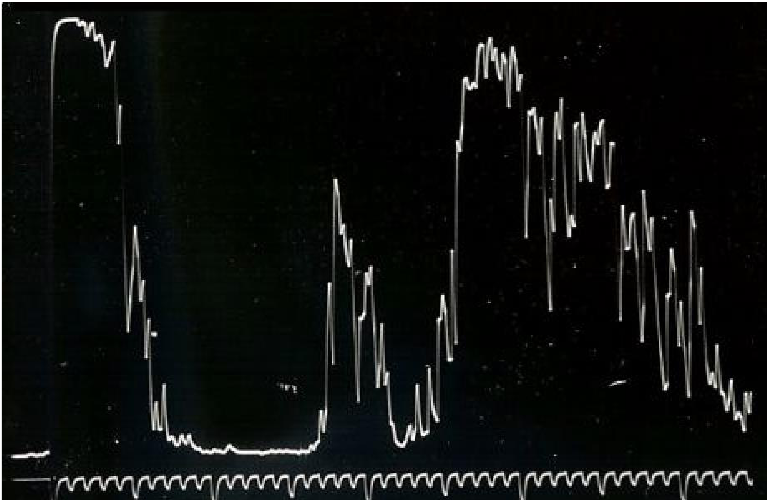
Figure 4. A-scan US reveals medium to low internal reflectivity with vascular pulsations.